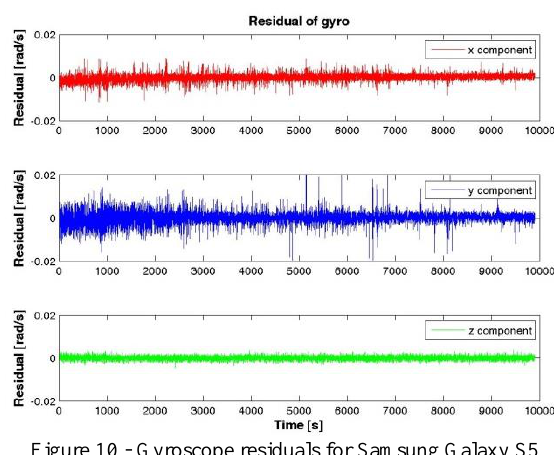
Figure 9- Acceleration residuals for Samsung Galaxy S5